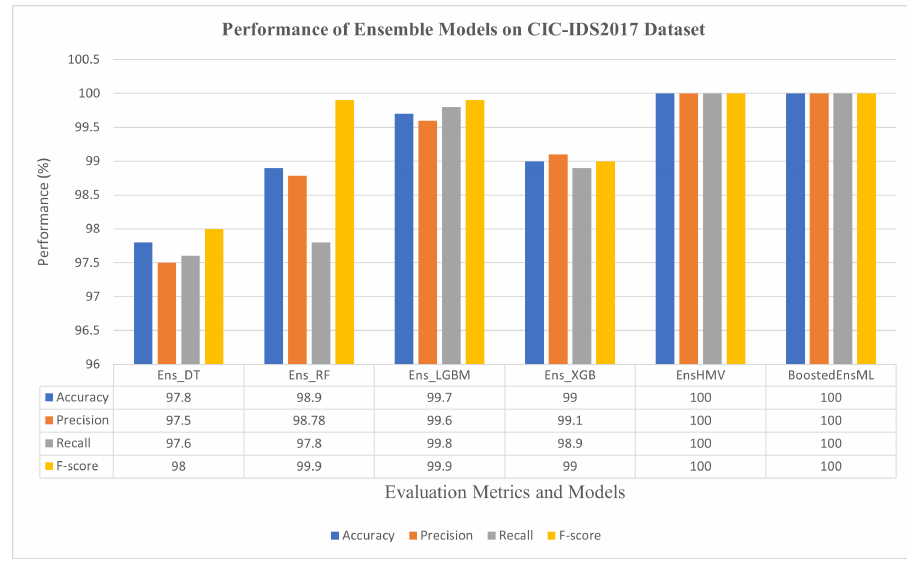
Figure 3. Performance evaluation of ensemble models on the CIC-IDS2017 dataset.